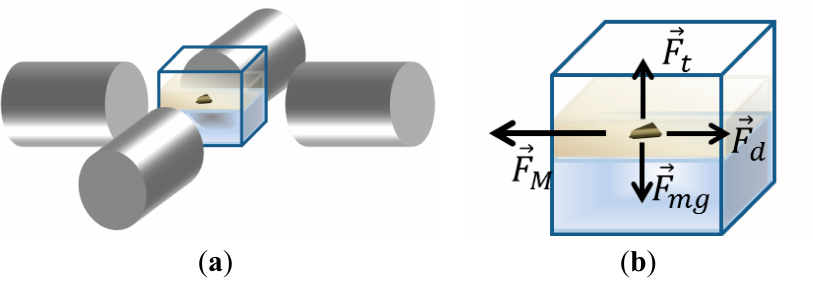
Figure 1. ( a ) Two electromagnet pairs arrayed about a ferromagnetic mass (the microrobot) operating in a fluid environment; and ( b ) the free body diagram of the microrobot in the